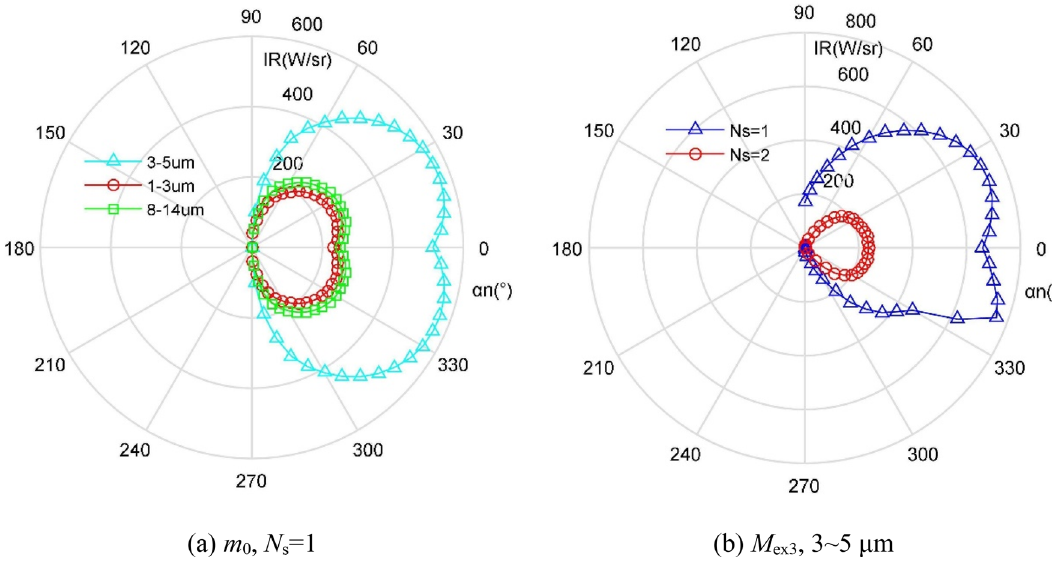
Figure 11. Aircraft IR signature under different wave bands and N s .